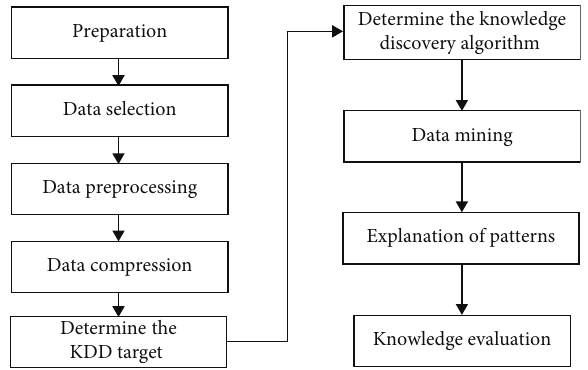
Figure 5: Process of